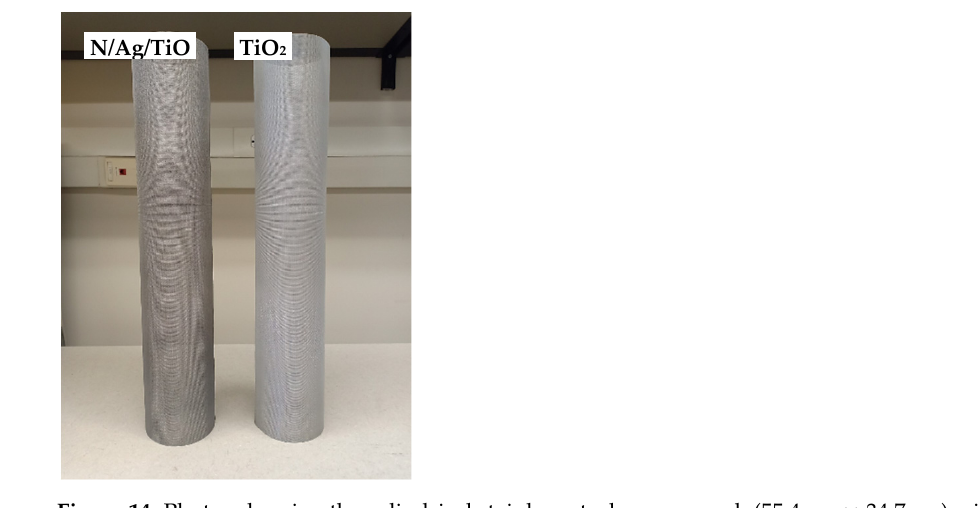
Figure 14. Photos showing the cylindrical stainless-steel woven mesh (55.4 cm × 34.7 cm) with the immobilized N/Ag/TiO 2 and bare-TiO 2 photocatalysts.